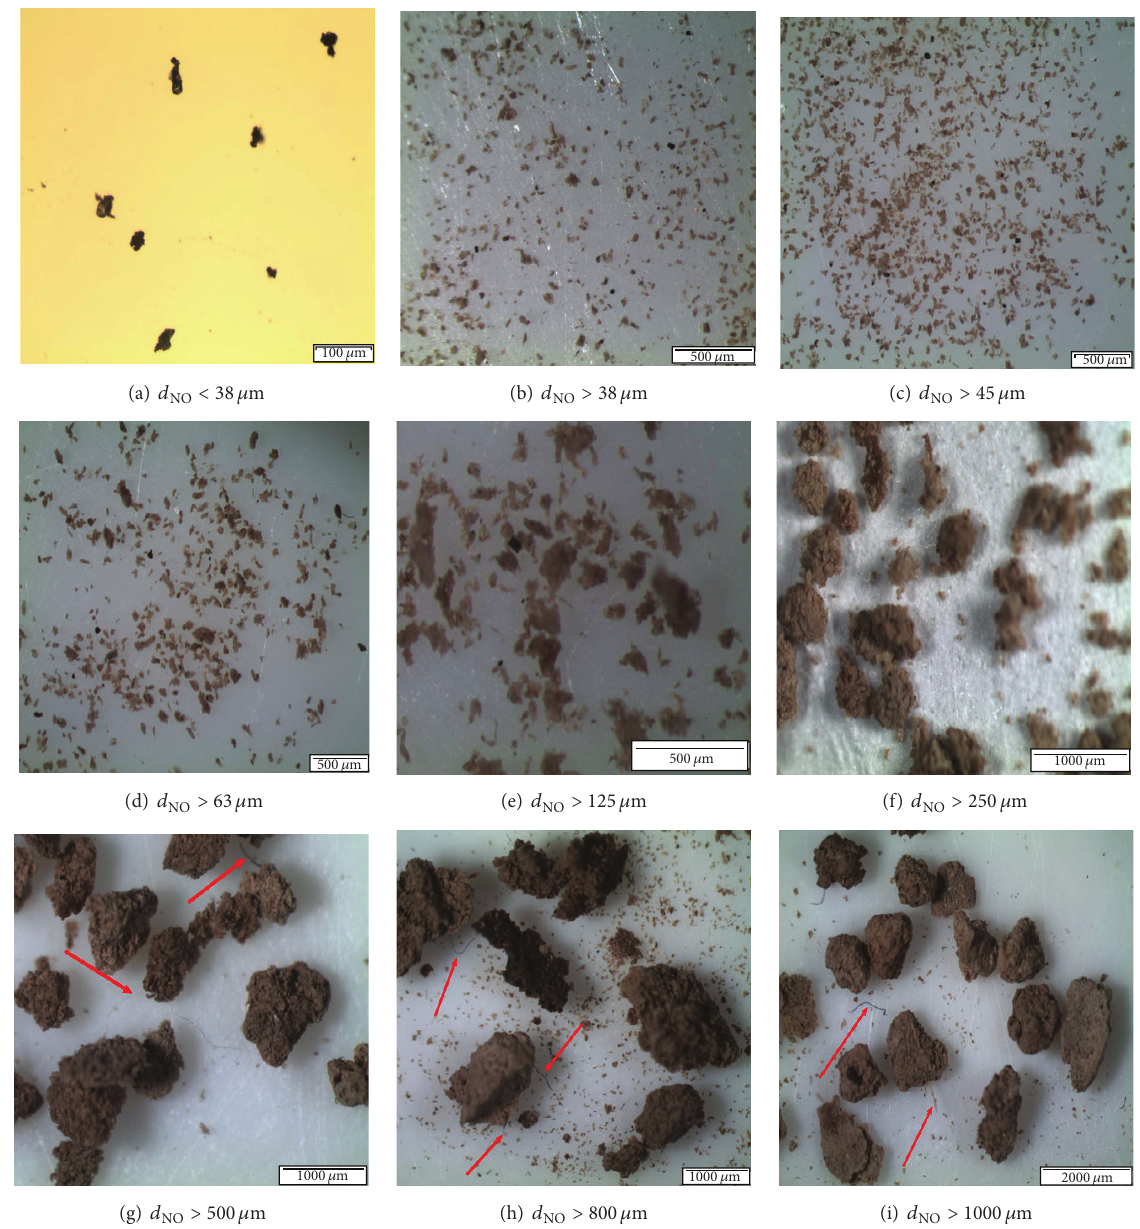
F 6: Images of non-oily POME sediments at different sieve opening